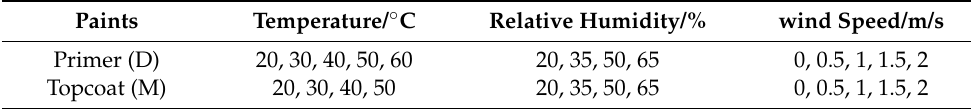
Figure 1. Painting process. Table 2. The drying conditions for WBP films.